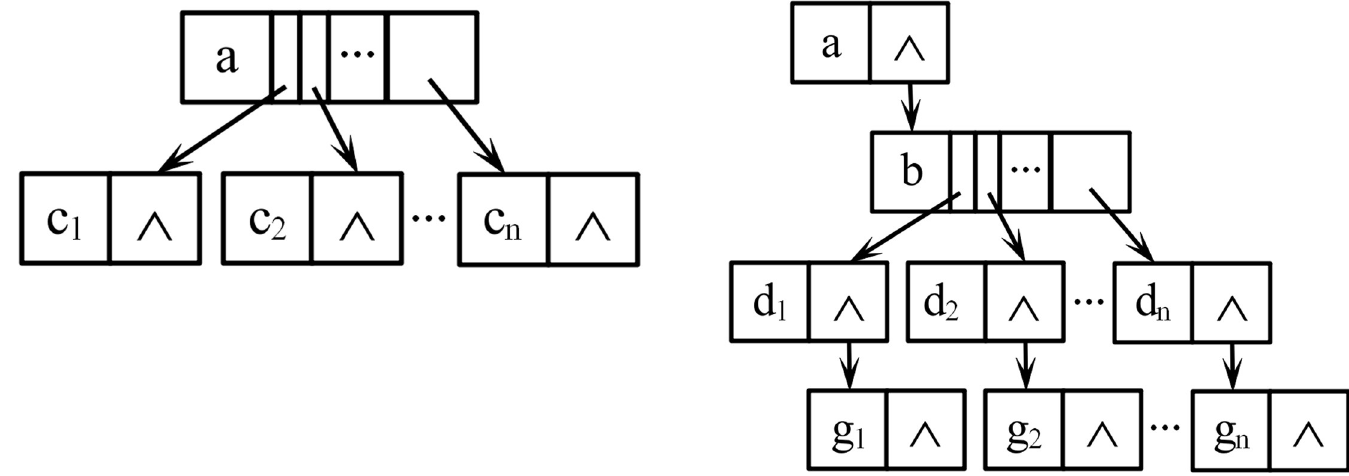
Fig 9. Storage structure of relationships among rhizomes. (a) Two level; (b) Four level.